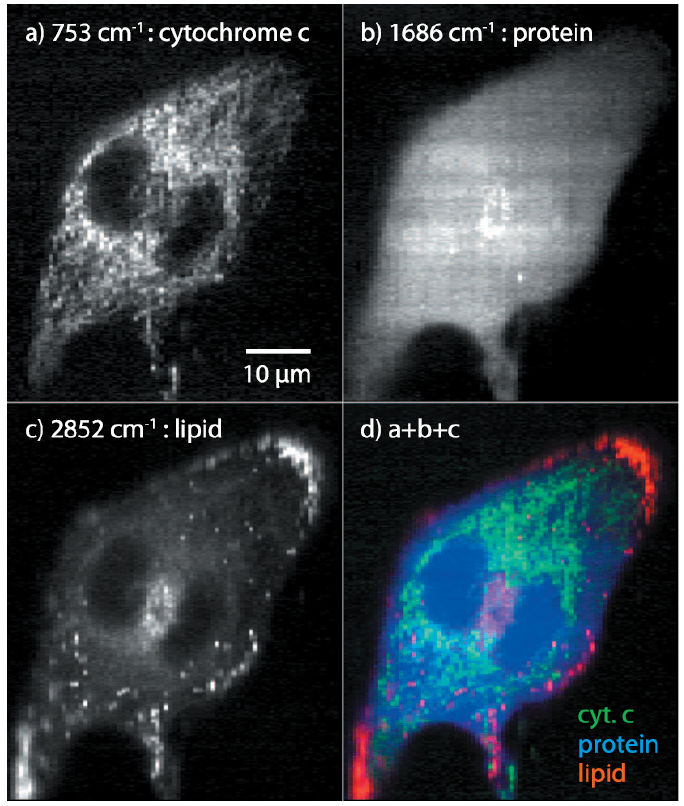
Figure 4. Raman scattering images of unstained, unlabelled living HeLa cells reconstructed using the distribution of Raman signals at (a) 753 cm − 1 , (b) 1,686 cm − 1 , and (c) 2,852 cm − 1 , showing the distribution of cytochrome c, protein beta sheet, and lipid molecules, respectively. Image (d) was constructed by merging images (a) through (c) with color channels. The sample was irradiated with a light intensity of 3.3 mW/µm 2 at the focal plane in 78 lines of exposure. The exposure time of each line was 5 s, and the images consist of 78 × 281 pixels. © Society of Photo-Optical Instrumentation